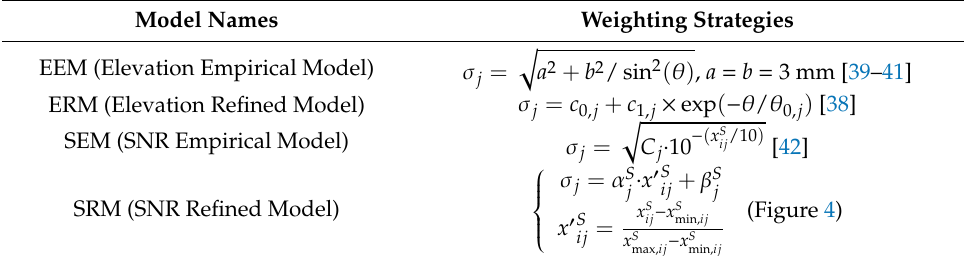
Table 1. Four weighting models and